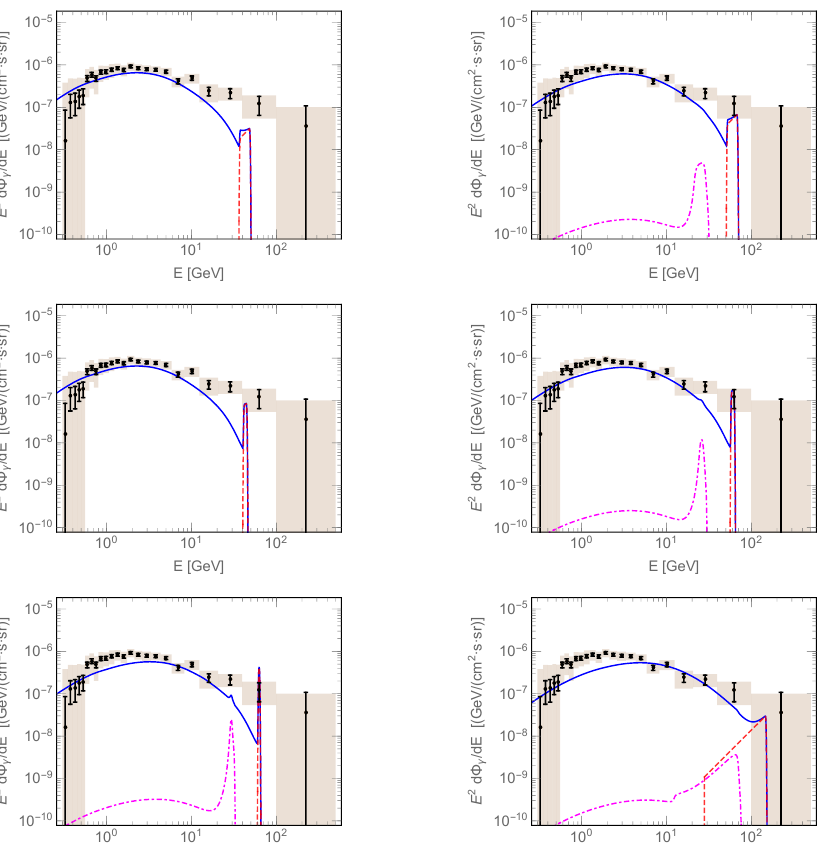
Figure 5 . Same as (cid:12)gure 4, but the detector energy resolution (cid:24) = 0 : 02 is taken. The best-(cid:12)t values of m X and h (cid:27)v i given in table 1 are used in the left panel, while the best-(cid:12)t values are further rescaled by 1.4 times in the right